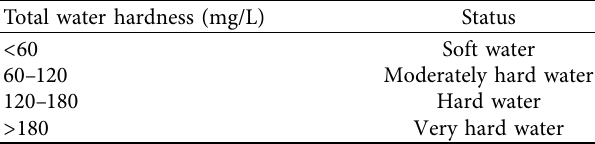
Table 1: Water hardness